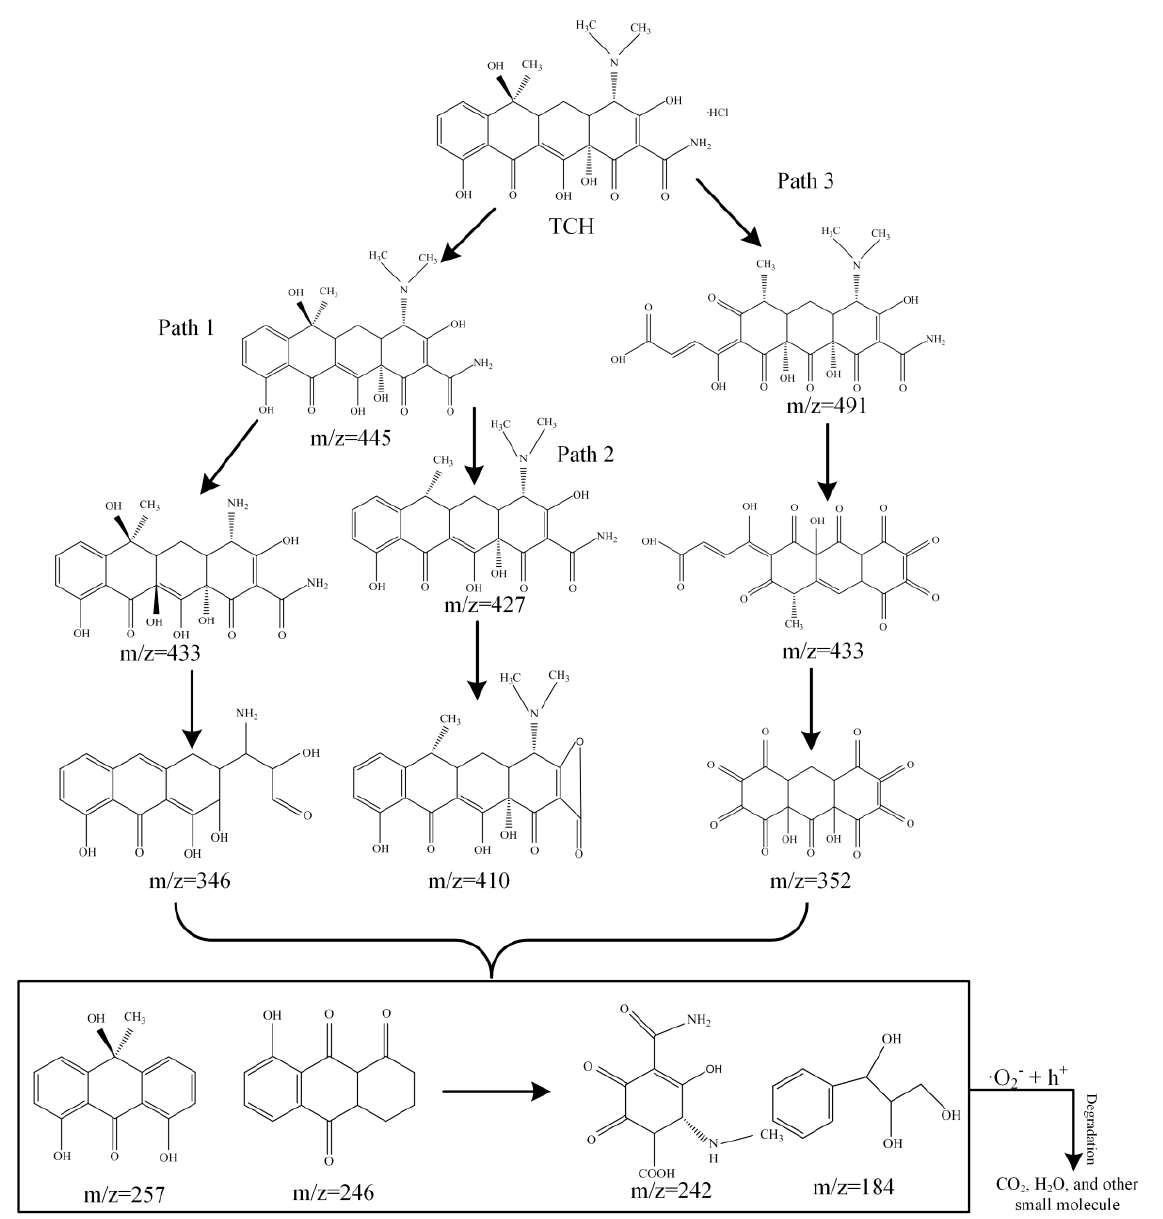
Figure 4. The proposed photodegradation pathways of TCH.